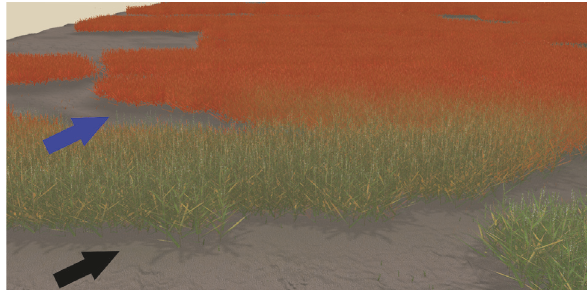
Figure 20: The plant models (green) cast different shadows than the billboards (red). The shape of the plant can be seen in the shadows cast by the plant models (see the shadows pointed by the black arrow), which is not visible in the shadows (see the blue arrow) that have been approximated for the